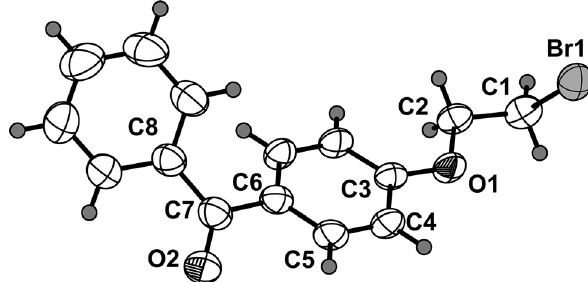
Table  : Data collection and